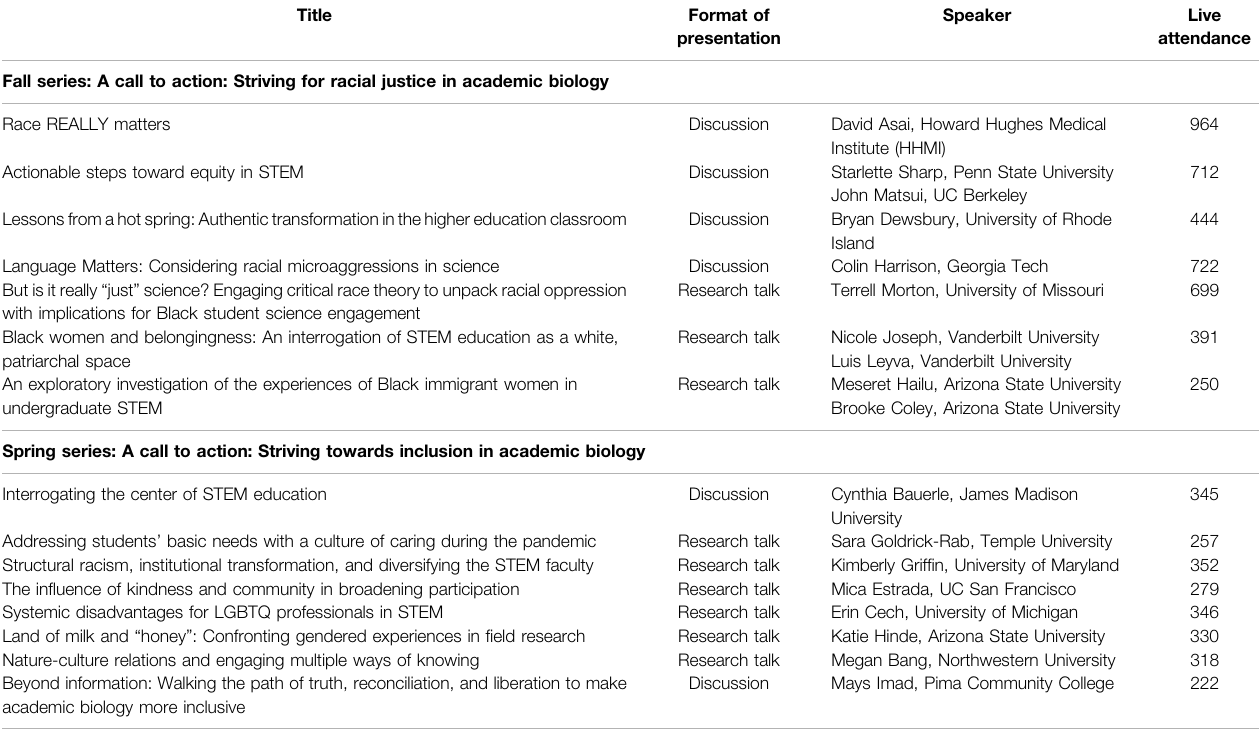
TABLE 4 | Summary of talk titles, speakers, and live attendance for the SABER virtual inclusion seminar